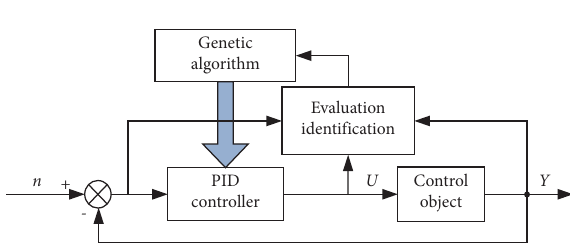
Figure 2: Principle of the genetic-PID controller.